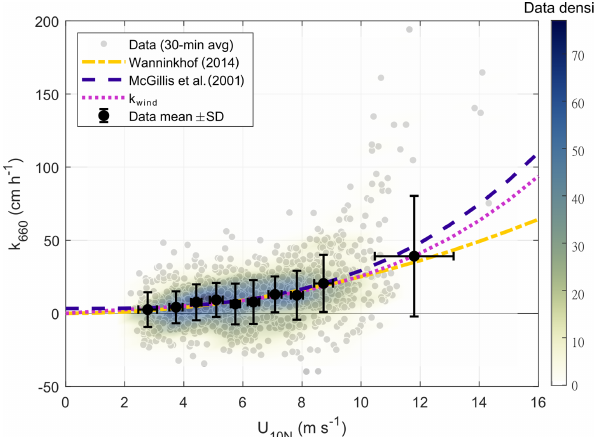
Figure 5. Gas transfer velocity for CO 2 (adjusted to a Schmidt number of 660) as a function of the 10m neutral wind speed. The grey dots represent the half-hourly values of k 660 for the 9-year period from 2013 to 2021. The black dots and bars represent the k 660 mean values and standard deviations, respectively, calculated for equidensity bins based on the wind-speed percentiles; the best fit to the means is shown as the dotted pink line ( k wind ). For ref- erence, quadratic (Wanninkhof, 2014) and cubic (McGillis et al., 2001) wind-based parametrizations are included. The colours in the shaded area represent the data density (in counts) with a grid bin size of 1ms − 1 by 10cmh − 1